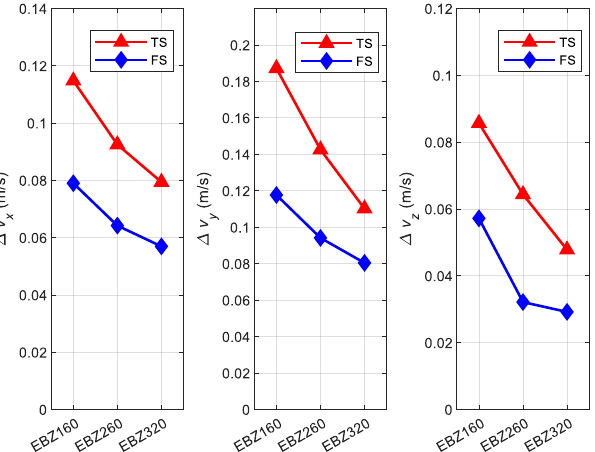
Figure 13. The sculling error statistics using three-subsample (TS) compensation algorithm and four-subsample (FS) compensation algorithm under different types of roadheaders. Figure 12 is the coning error statistics using the three-subsample (TS) Table 4. The technical parameter table of roadheader.